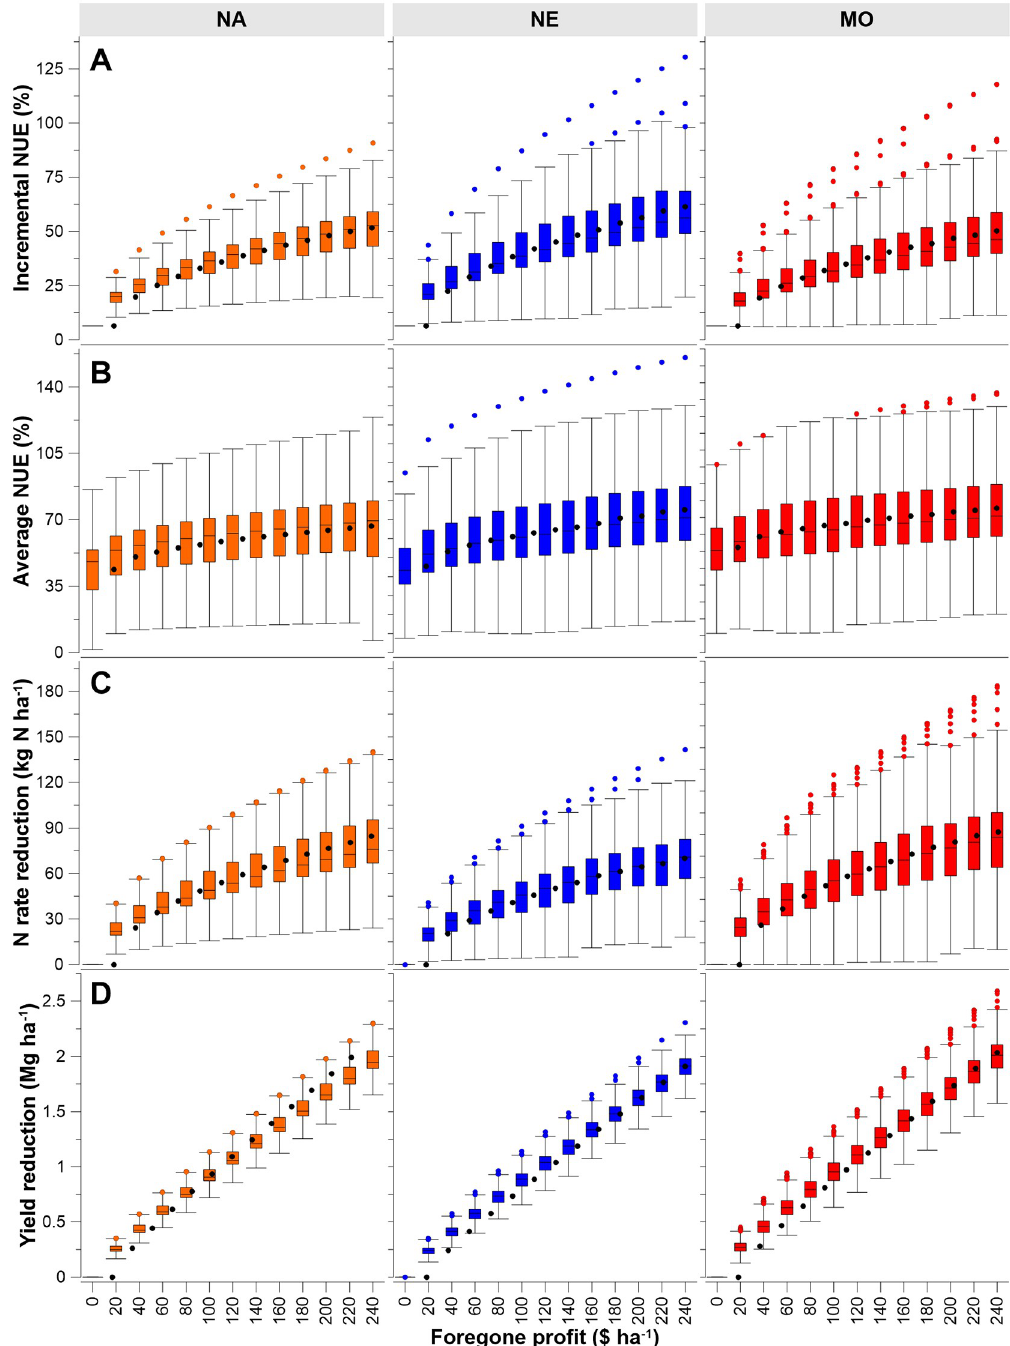
Fig 5. Realize large improvements in average NUE by removing low iNUE. (A) Incremental NUE for the three datasets shown corresponding to foregone profit. (B) Average NUE [(grain Nx–grain N0)/x; x = N rate)] shown relative to foregone profit. (C) Nitrogen saved (EONR- N rate) shown relative to foregone profit. (D) Yield reduction (or loss) with sub-EONR fertilization shown relative to foregone profit. With each graph, box limits are the first and third quartile, whiskers indicate 1.5 times the interquartile range, circles indicate outliers, the box line is the median, and the black circle is the mean.